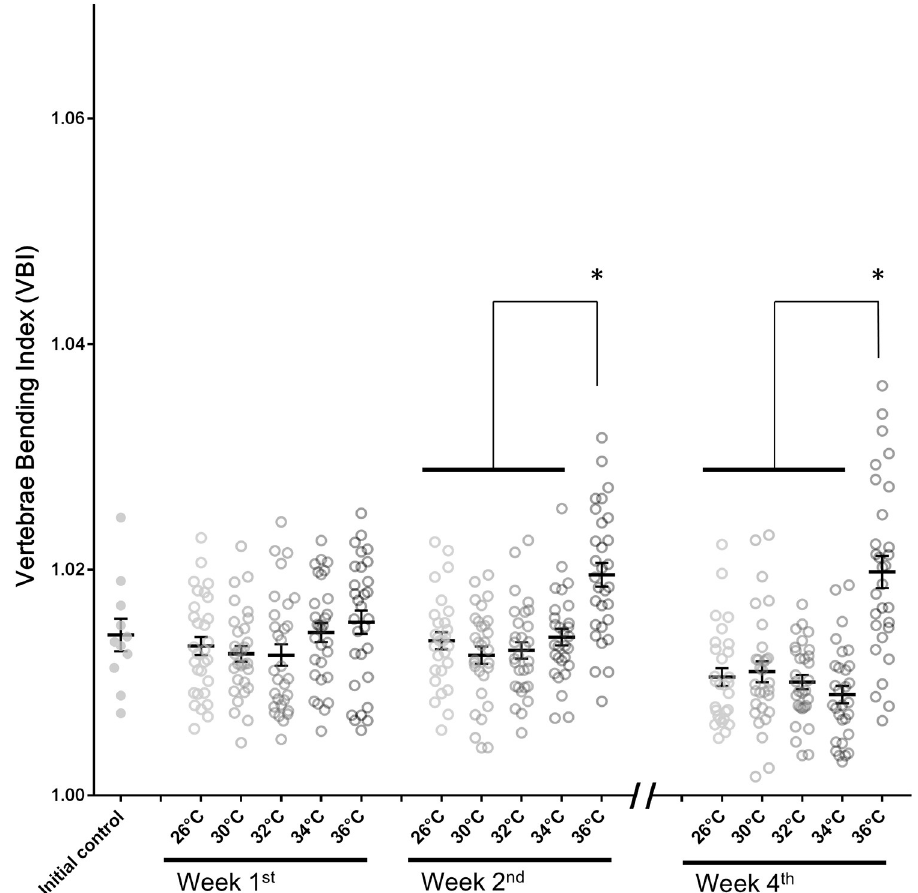
Fig 3. Vertebrae bending index (VBI) of fish kept under different temperatures in Experiment 1. Mean ± SEM, ( � p <